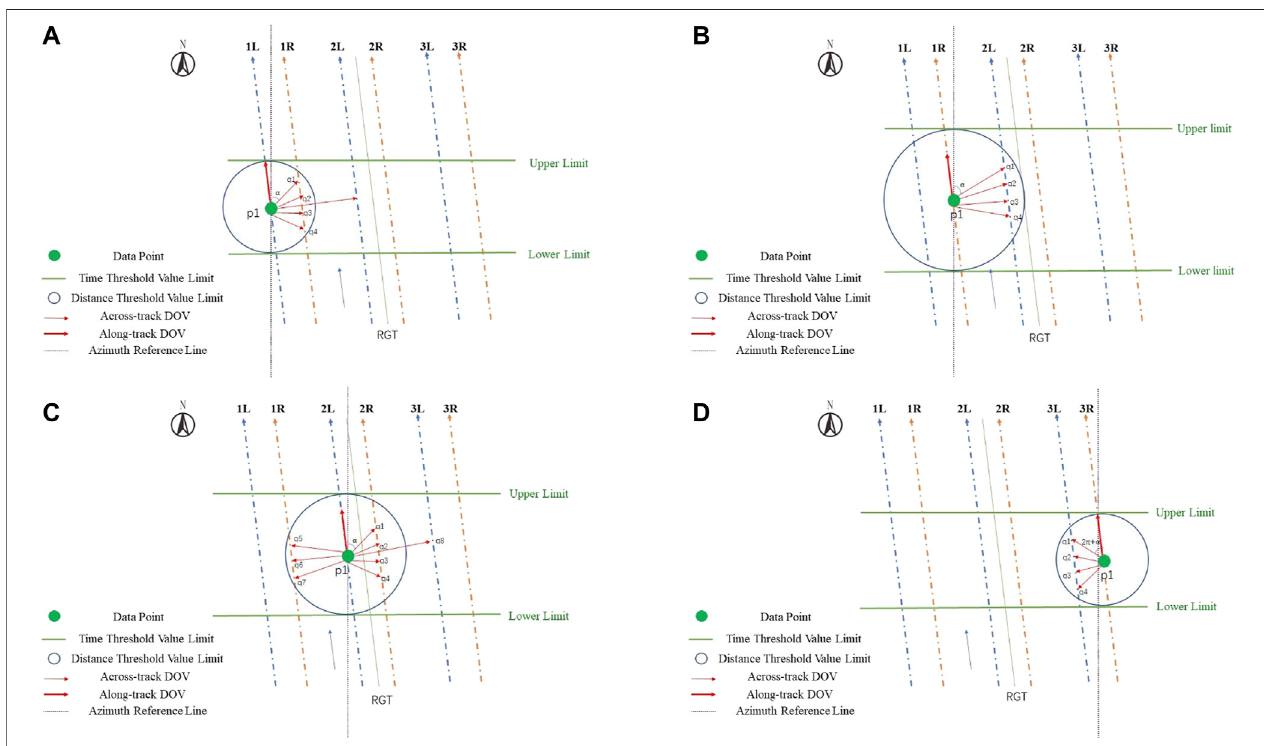
FIGURE2|(A) Jointcalculationbetweenthesamegroupofbeams(left-to-right), (B) jointcalculationbetweendifferentgroupsofbeams(left-to-rightorright-to-left), (C) joint calculation between different groups and the same group of beams (left-to-right and right-to-left), (D) joint calculation between the same group of beams (right-to-left).